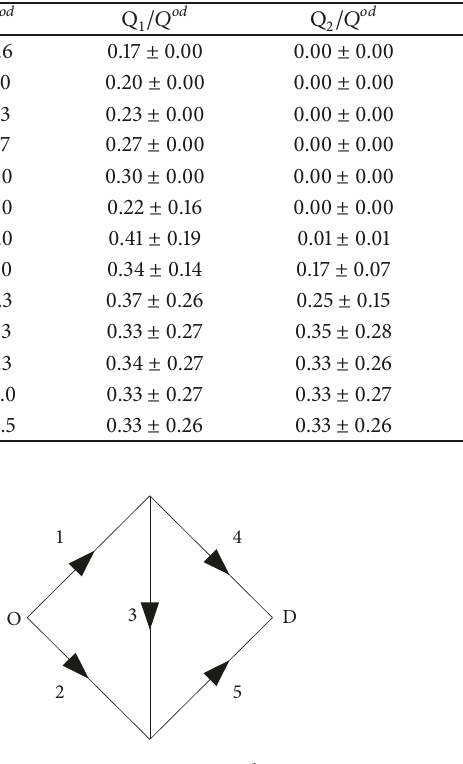
Figure 1: Braess